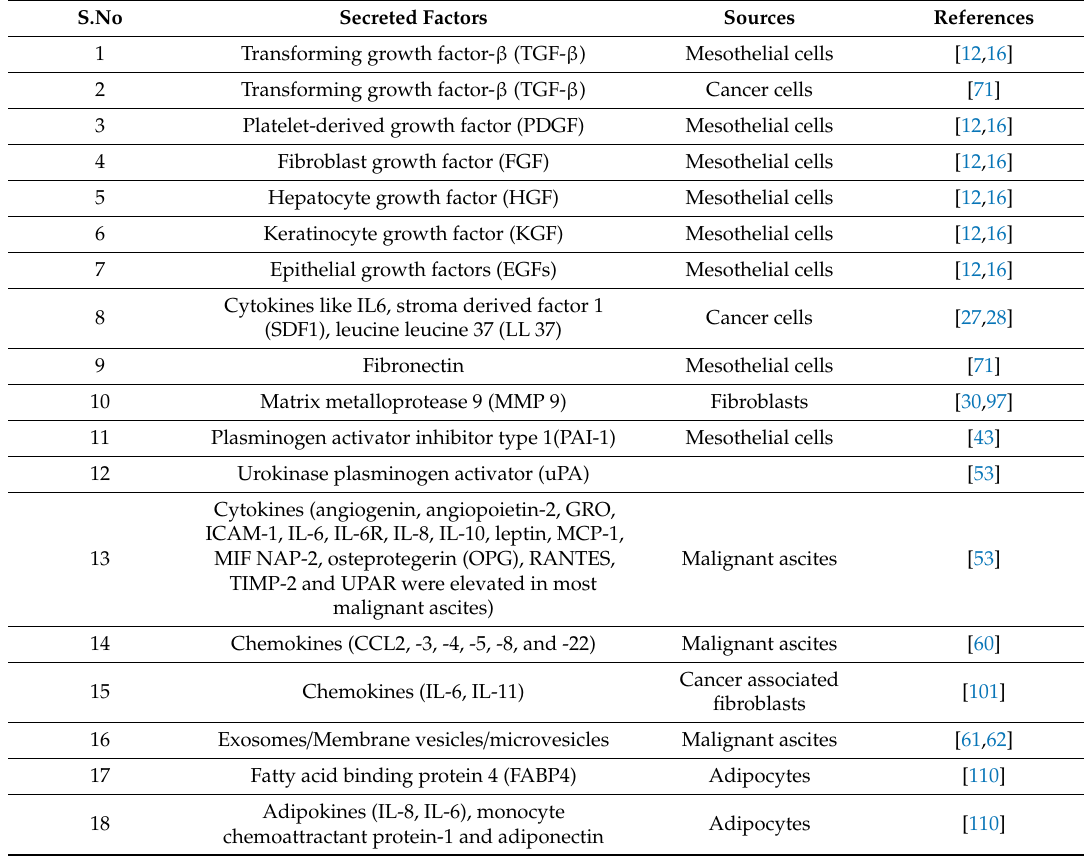
Table 1. Secreted factors involved in reciprocal interactions between metastasizing ovarian cancer cells and the